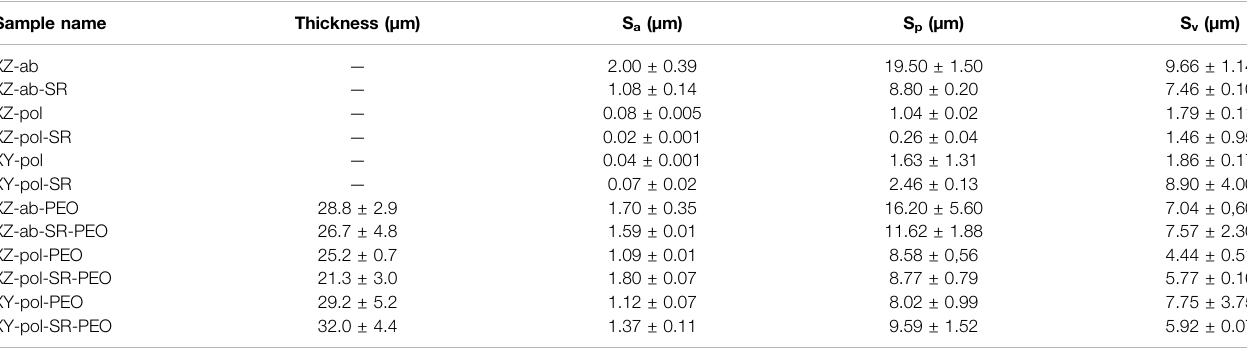
TABLE 2 | average PEO thickness and the roughness values of the surfaces. Sample